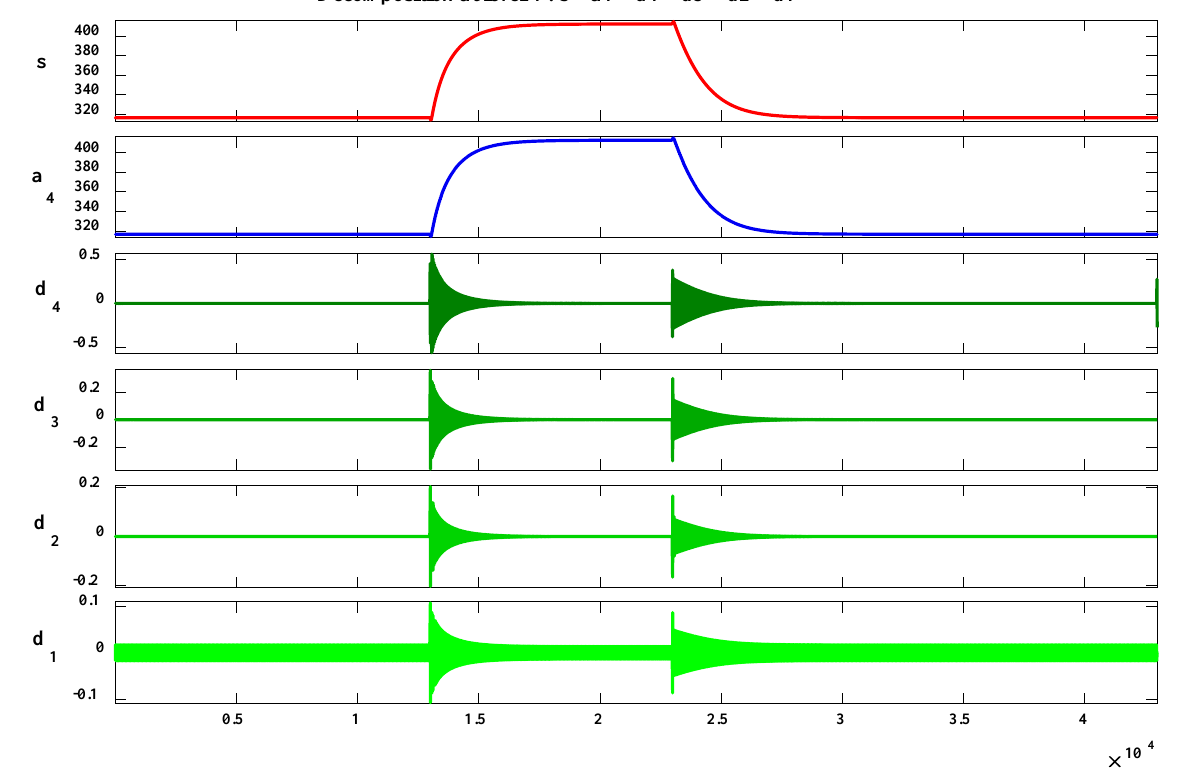
Figure 6. FDIA according to decreasing the voltage reference waveform amplitude: ( a ) Voltage Waveform, ( b ) Wavelet Figure 6. b) Wavelet decomposition. decomposition.